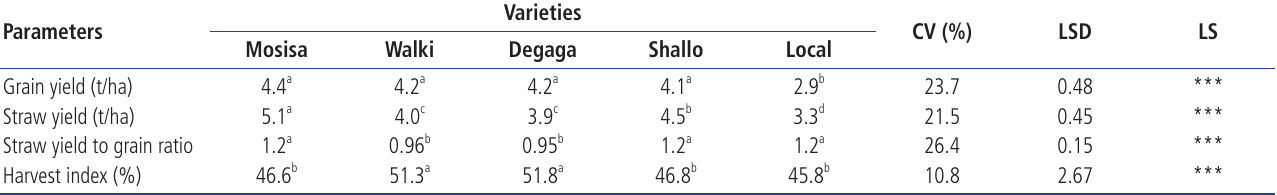
Table 1. Grain and straw yield, straws to grain ratio and harvest index of faba bean varieties extrapolated from 30 quadrants (1 m×1 m) each Parameters